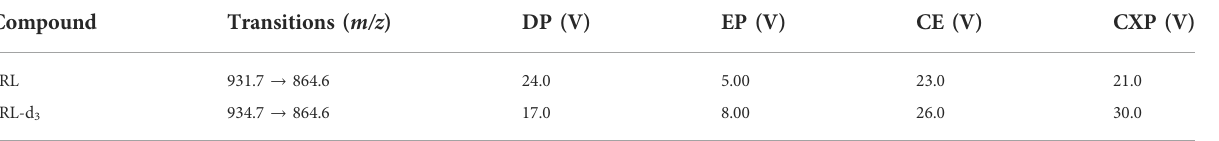
TABLE 2 MRM transitions and conditions of SRL and SRL-d 3 .